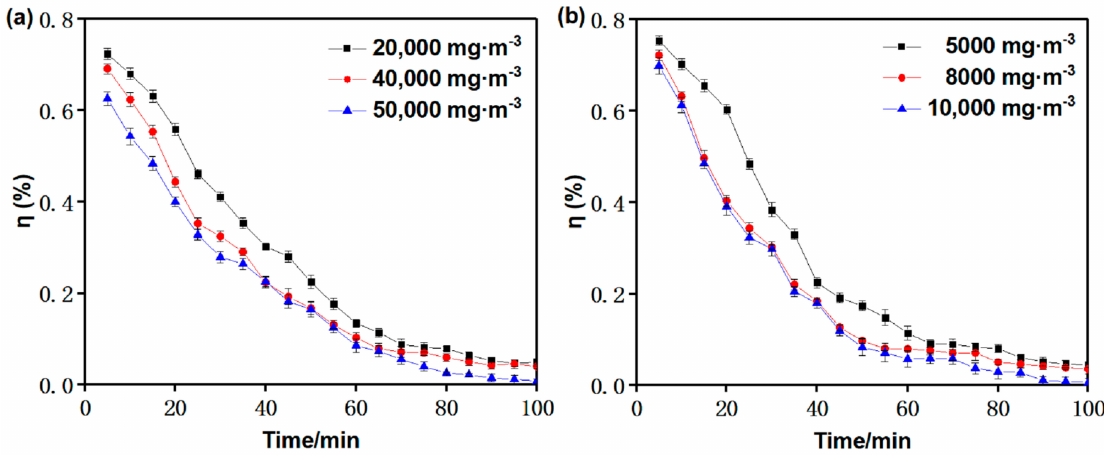
Figure 3. The influence of inlet gas concentration on the absorptivity for ( a ) DCM and ( b ) benzene (Q = 0.036 m 3 · h − 1 , T = 298.15 K, 60 wt% [HMIM][Cl]).